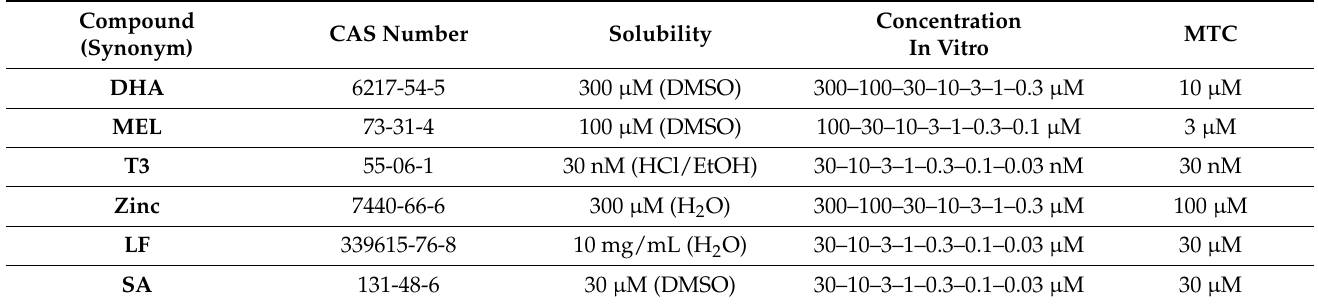
Table 2. In vitro testing concentrations of potential